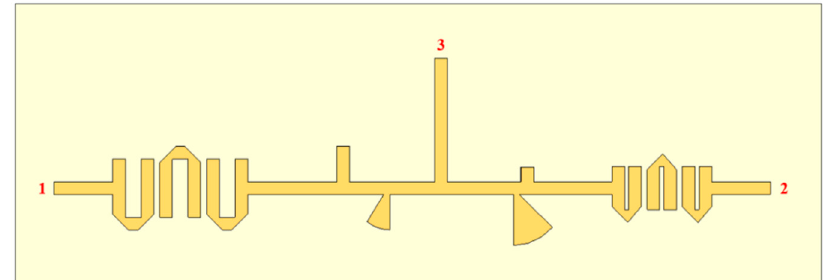
Figure 11. Structure of antenna feeding using filters. Sensors 2020 , 18 , x FOR PEER REVIEW